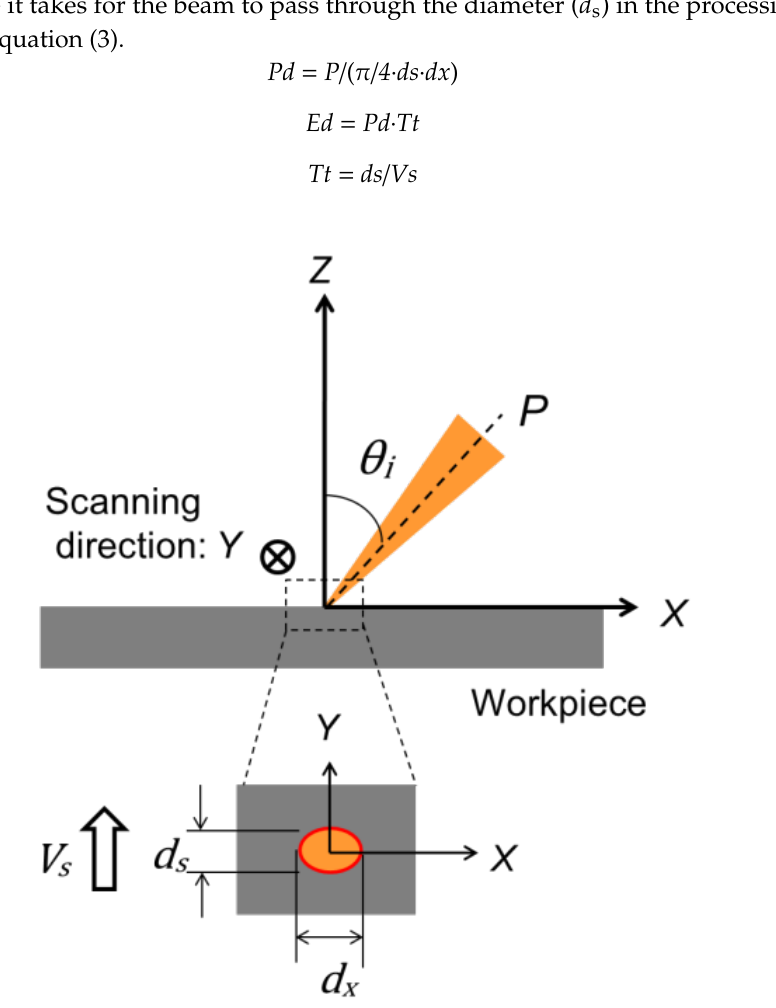
Figure 2. Schematic diagram of laser-irradiated area.